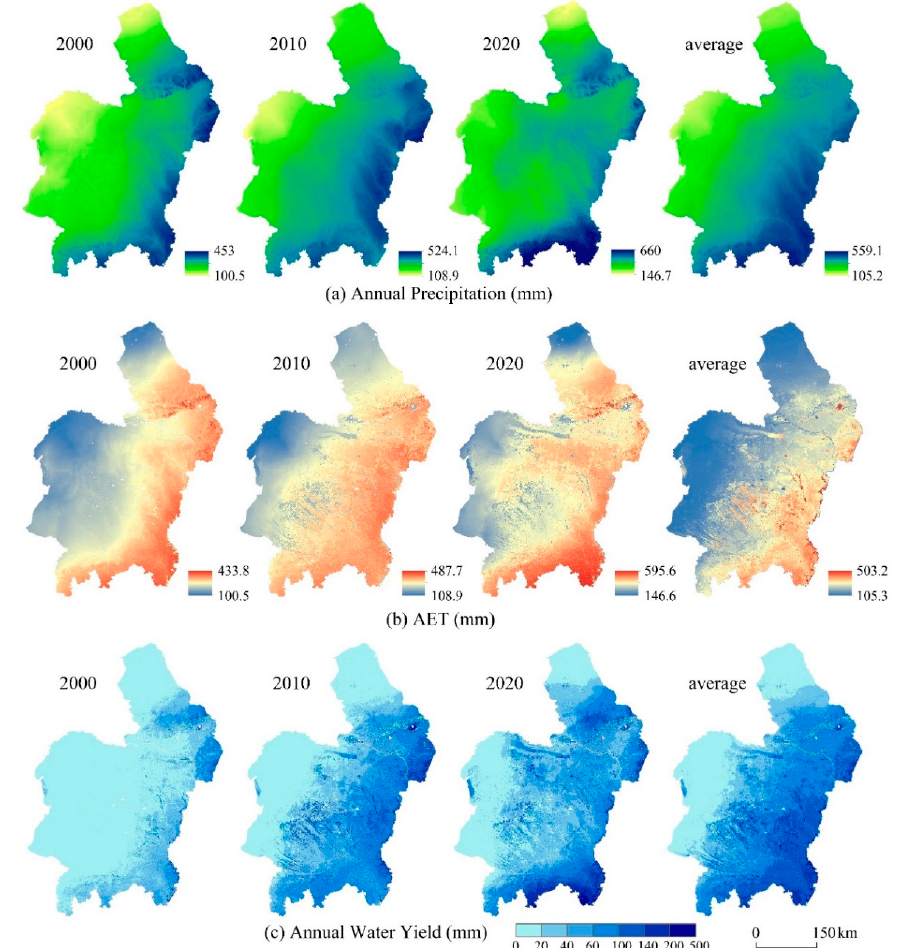
Figure 5. Spatial distribution annual precipitation ( a ), AET ( b ), and annual water yield ( c ) in the HBOY region.